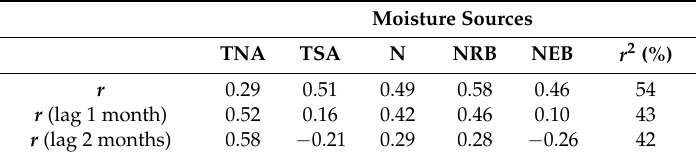
Table 3. Significant monthly correlations (at p < 0.05) between | (E − P)i10 < 0| from the sources and P over the MRB.